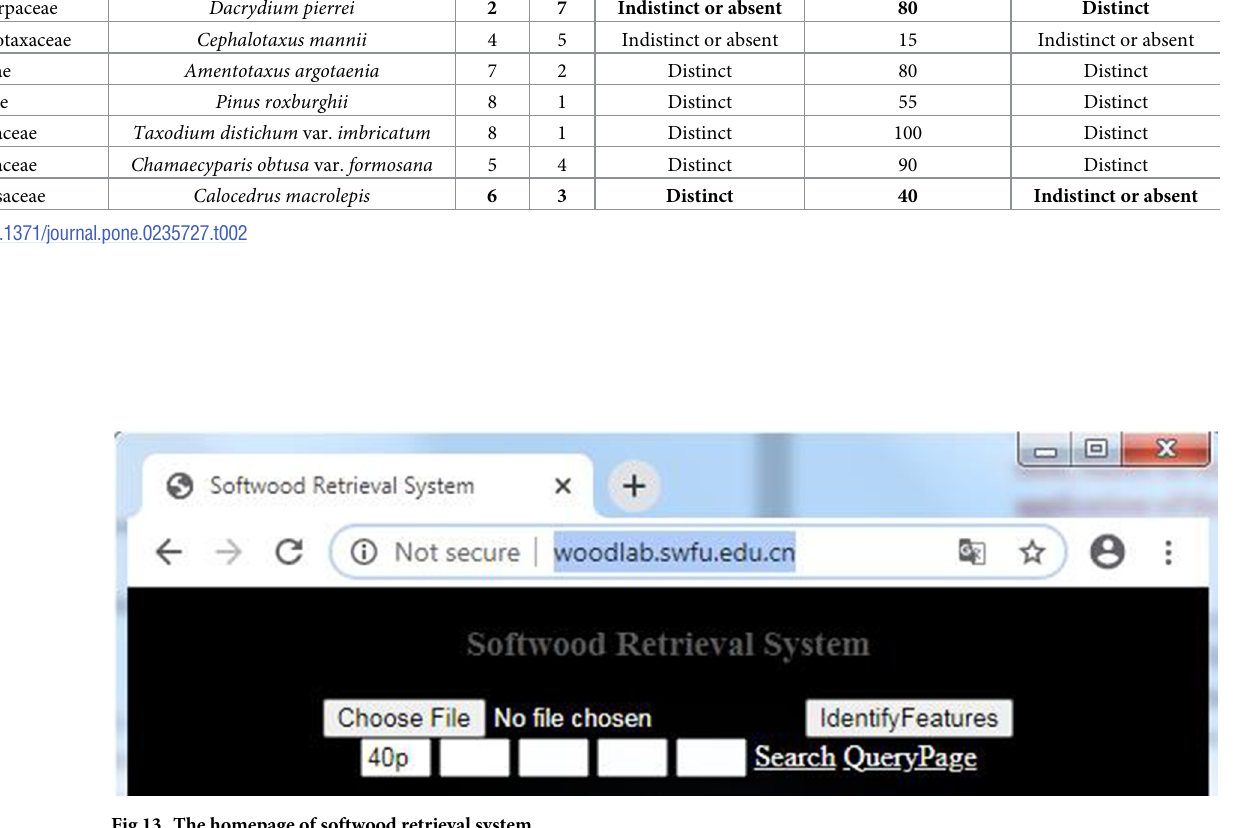
Fig 13. The homepage of softwood retrieval